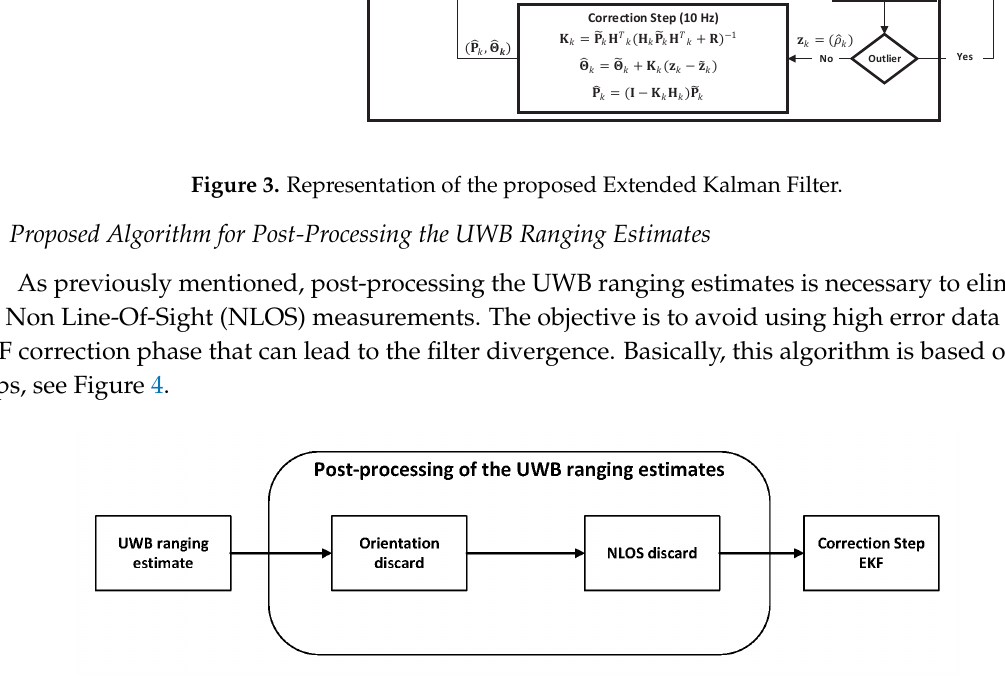
Figure 4. Architecture of the post-processing algorithm of the UWB ranging